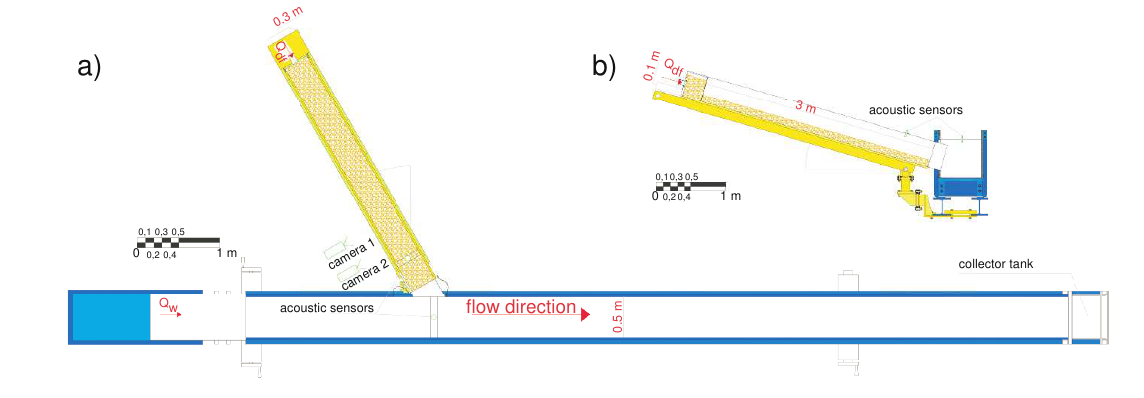
Figure 1. Experimental apparatus and locations of the various measuring devices adopted: ( a ) Plan view of the main channel and of the tributary channel; ( b ) Lateral view of the tributary channel and of its confluence with the main